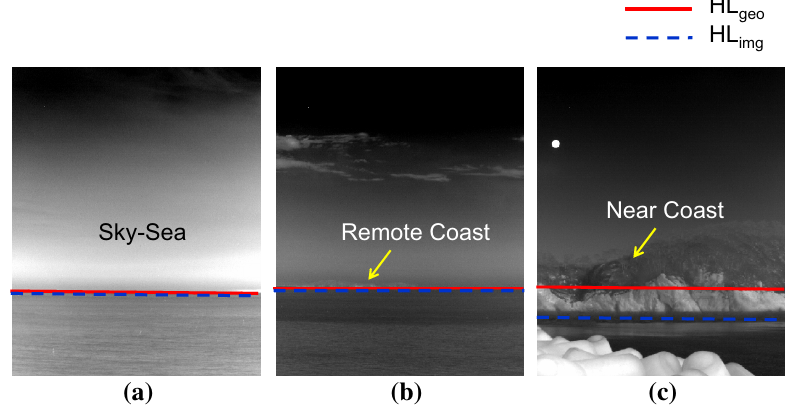
Figure 8. Horizon observation of the sea-based infrared images and background types: ( a ) normal sky-sea; ( b ) remote coast; ( c ) near coast background.